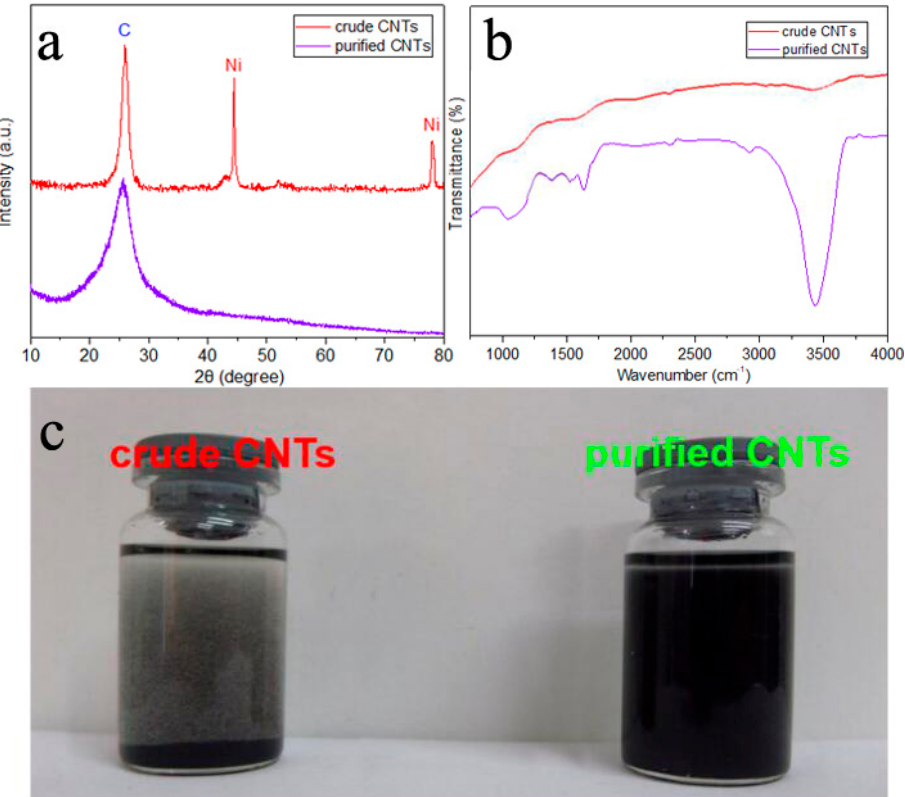
Figure 3. ( a ) XRD patterns of crude CNTs and purified CNTs; ( b ) FTIR spectrum of crude CNTs and purified CNTs; ( c ) the pictures of crude CNTs and purified CNTs dispersed in ethanol.